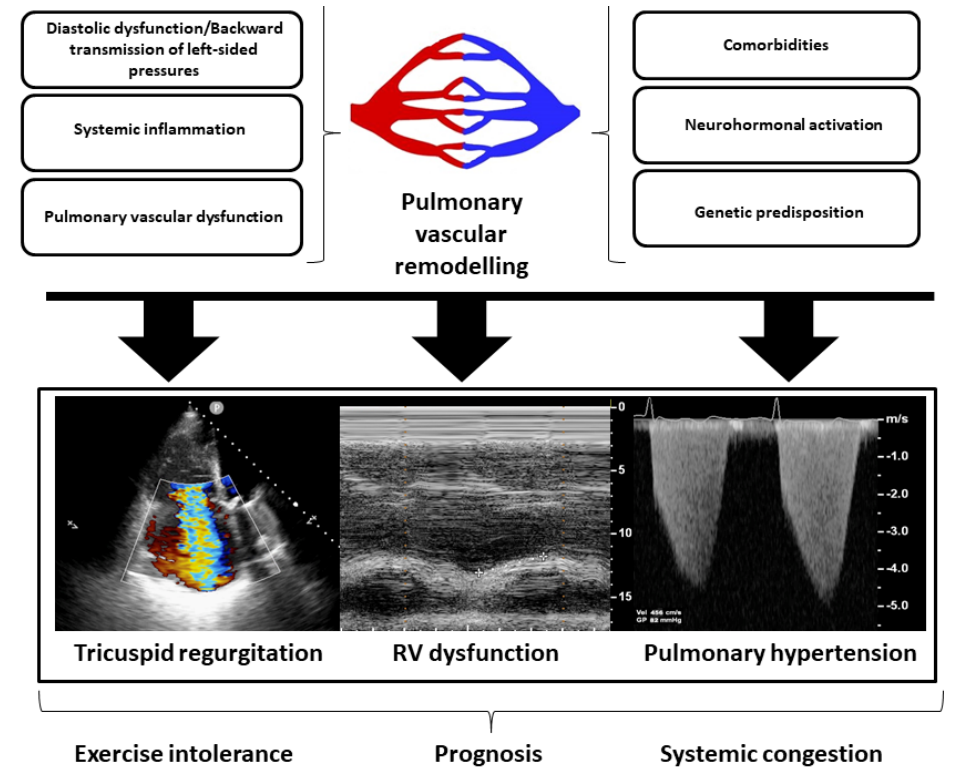
Figure 3. Pathophysiological pathways involved in right heart dysfunction (RHD) in heart failure with preserved ejection fraction (HFpEF). The passive backward transmission of left-sided pressure, comorbidities, systemic inflammation, neurohormonal pathways, genetic predisposition, and intrinsic lung and pulmonary vascular abnormalities are all factors interrelated in the pathogenesis of RHD in patients with HFpEF. Pulmonary vascular remodeling and the development of a pre-capillary component of pulmonary hypertension are key factors in developing RHD in HFpEF. Because of this pathophysiological pathways, right ventricular dysfunction, pulmonary hypertension, and functional tricuspid regurgitation are the main drivers of exercise intolerance, systemic congestion, and prognosis in HFpEF. RV: right ventricular.